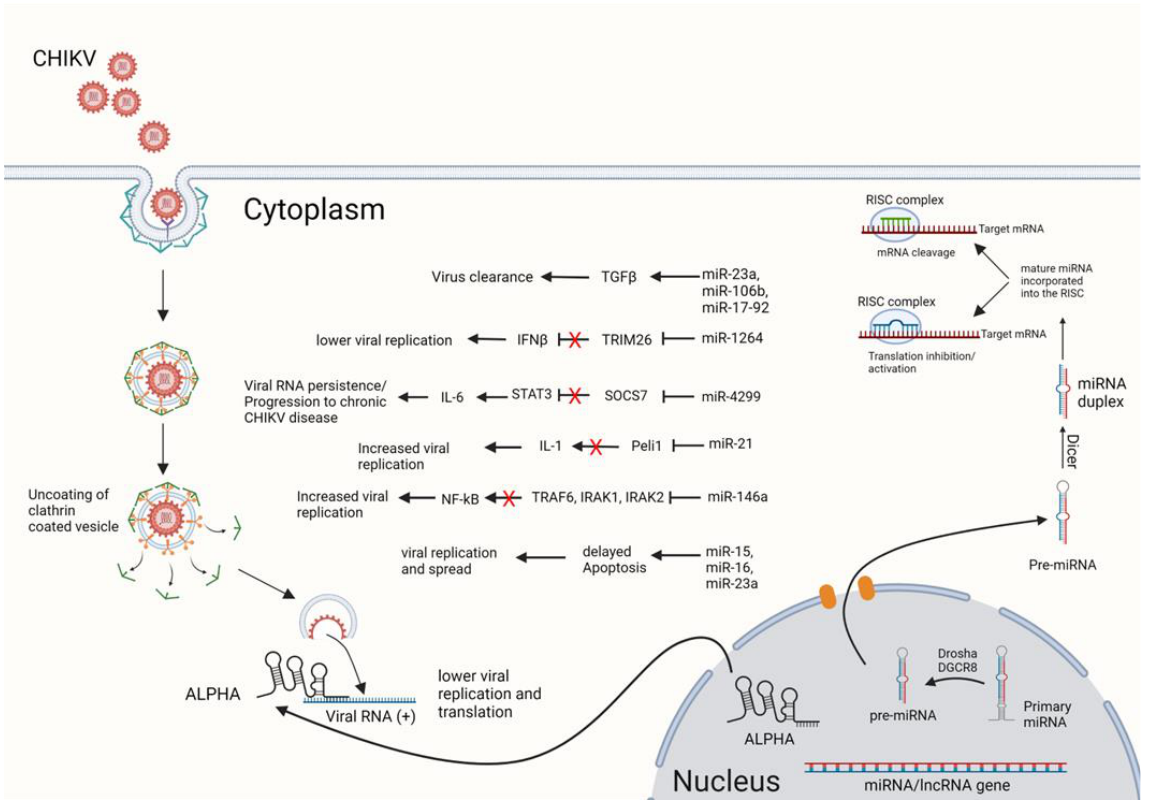
Figure 1. Summary of miRNA/lncRNA response in CHIKV-infected mammalian cells. CHIKV infection modulates miRNA/lncRNA expression in mammalian cells, such as fibroblasts. Alteration of immune-related genes’ transcript levels or translation of their mRNAs results in modulation of the immune response to CHIKV infection, leading to pro- or antiviral effects. The lncRNA ALPHA decreases CHIKV replication and protein translation by directly binding to the viral genome. Image created using BioRender.